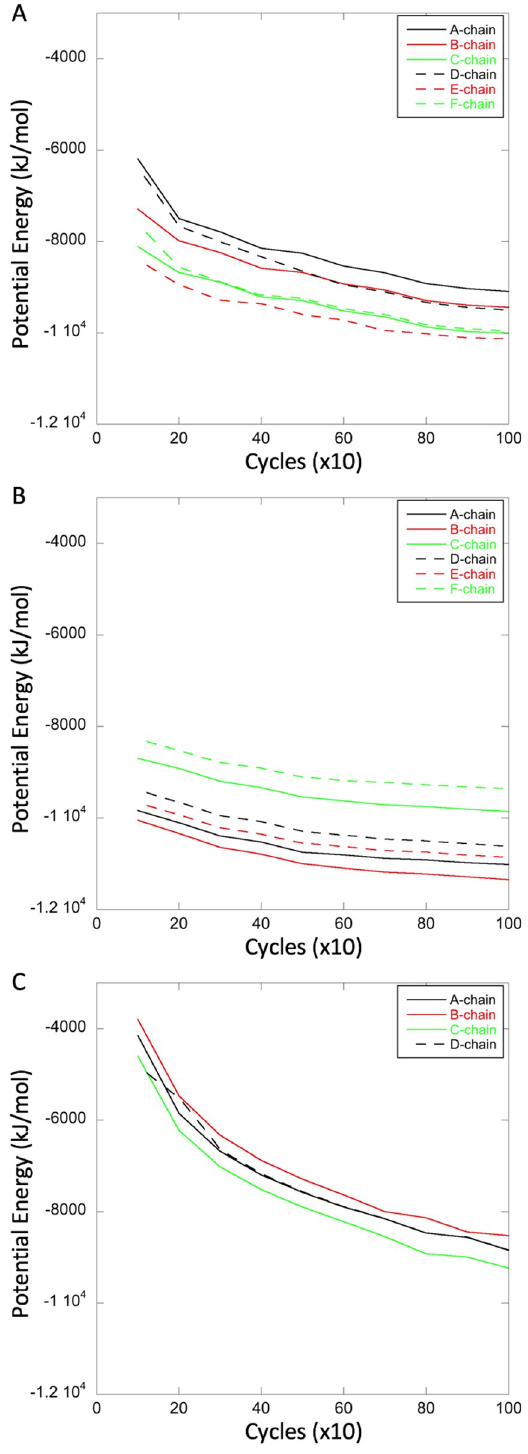
Fig 5. Comparison of potential energy minimization curves of hypothetical monomer chains from non-capsid and capsid dimers. Compared are apo 3KXS (A) and liganded 5E0I (B) non-capsid chains with the apo T = 4 1QGT capsid chains (C). All are X-ray crystal structures of comparable resolution. There is no apo T = 3 capsid X-ray crystal structure available for comparison. The non-capsid profiles (A and B) are similar to each other, and distinct from the capsid profiles (C), showing both lower energy and less decrease with progressive